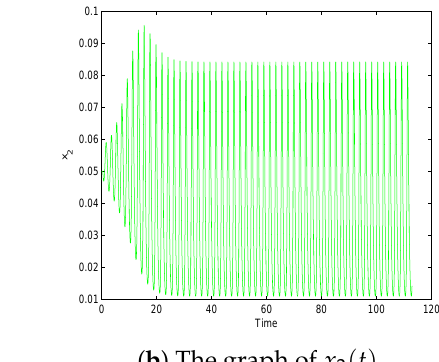
( b ) The graph of x 2 ( t ) .